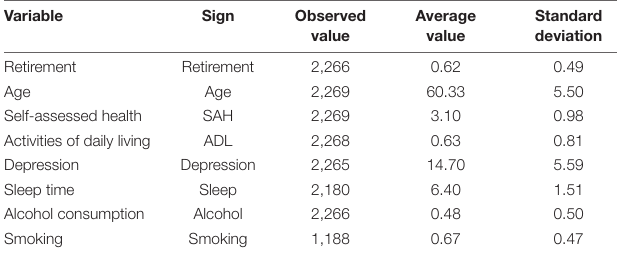
TABLE 2 | Descriptive statistics of the